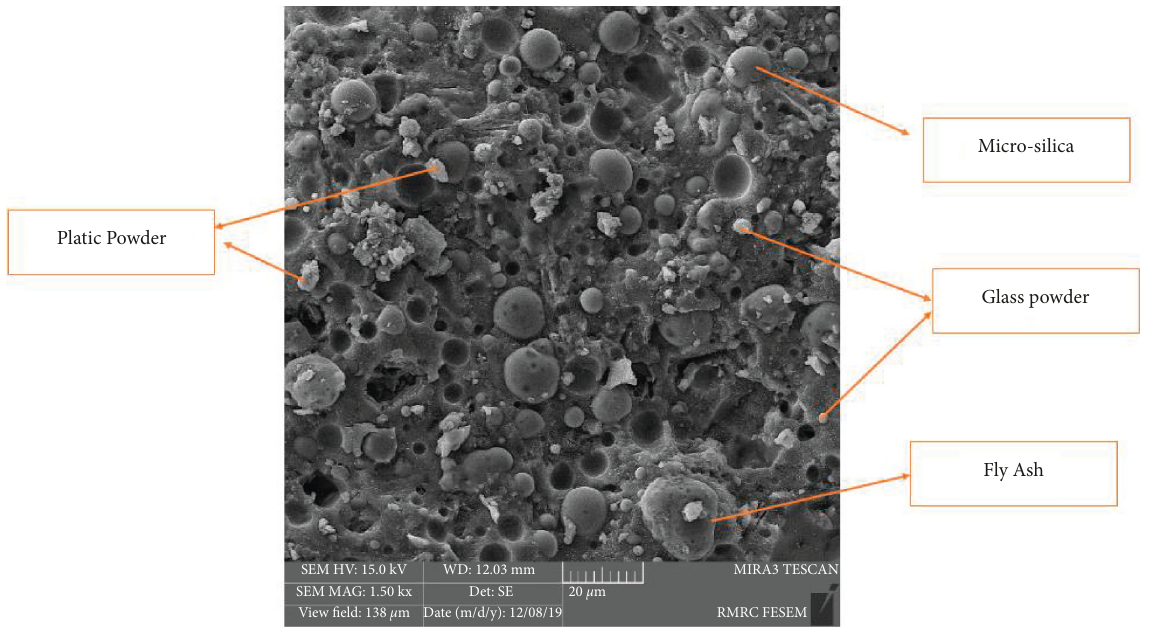
Figure 8: Effect of sustainable materials on concrete (C30R10) [46].